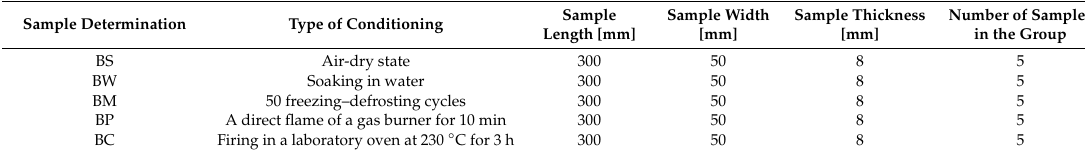
Table 1. The conditioning and testing